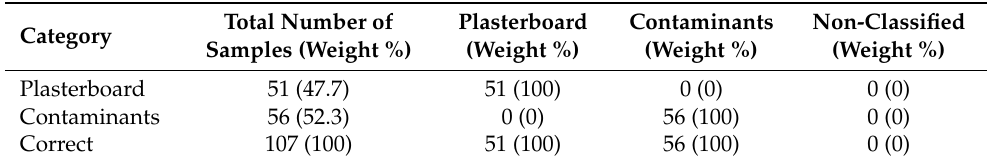
Table 4. Confusion matrix for the calibration model.